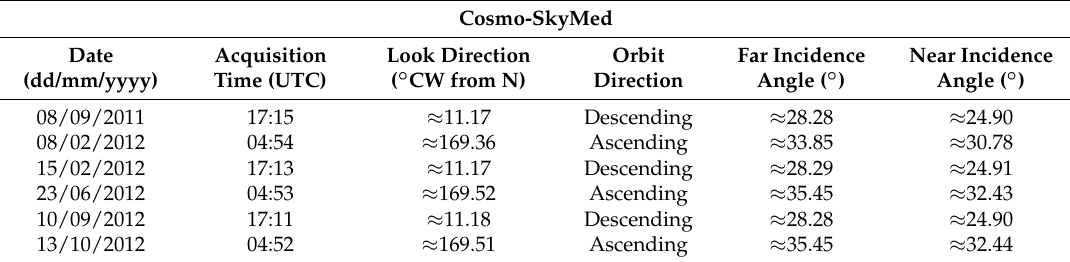
Table 3. TSX acquisition parameters.